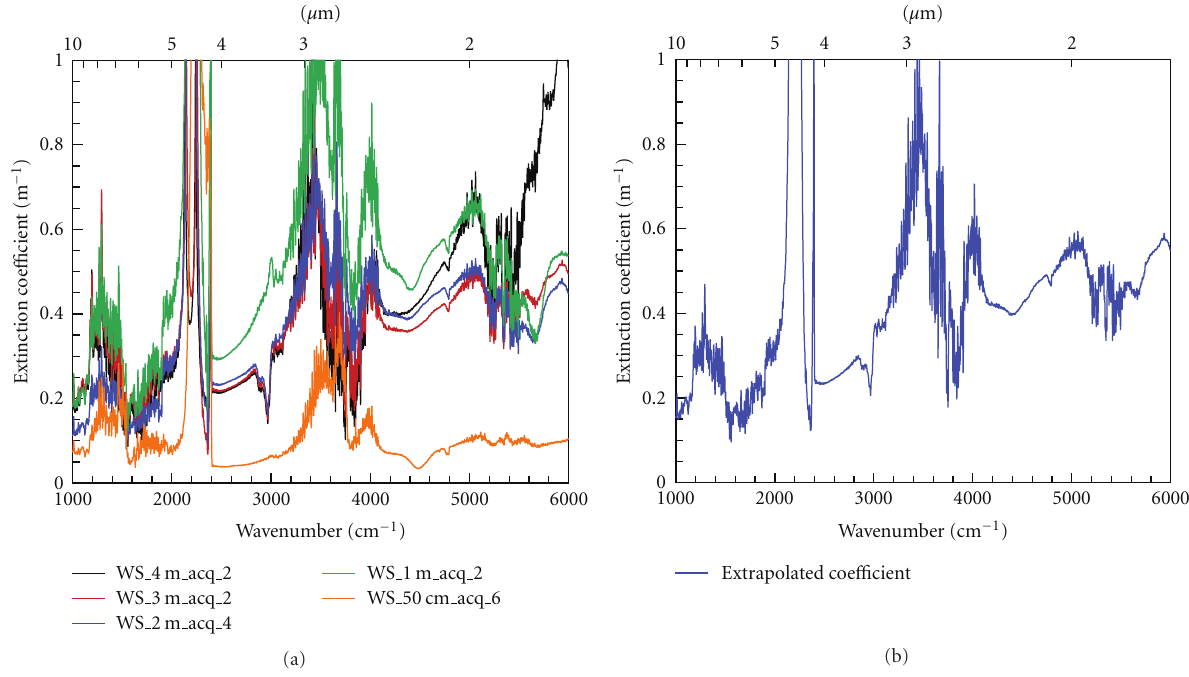
Figure 7: (a) Extinction coe ffi cient versus wavenumber (and wavelength) and (b) averaged extinction coe ffi cient versus wavenumber (and wavelength). WS are used as fuel, with a fuel load of 1kg/m 2 .